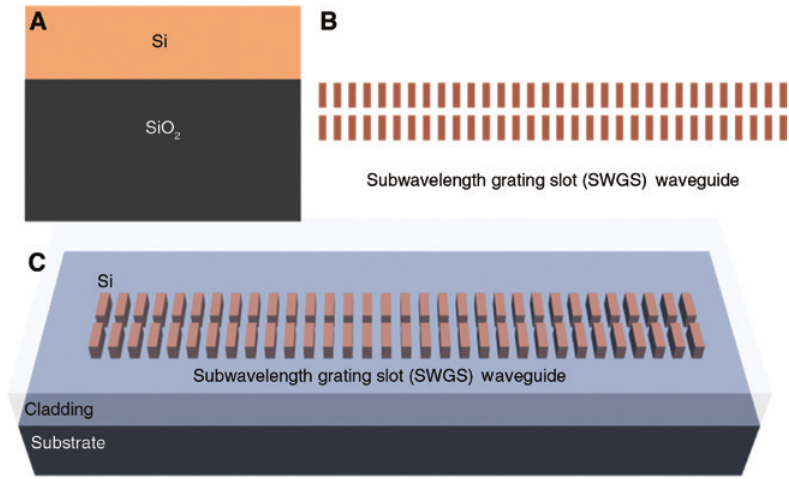
Figure 1: Schematic illustration of silicon platform and SWGS waveguide. (A) Illustration of an SOI wafer to form various silicon waveguides. (B) Top-view structure of the SWGS waveguide. (C) 3D structure of a SWGS